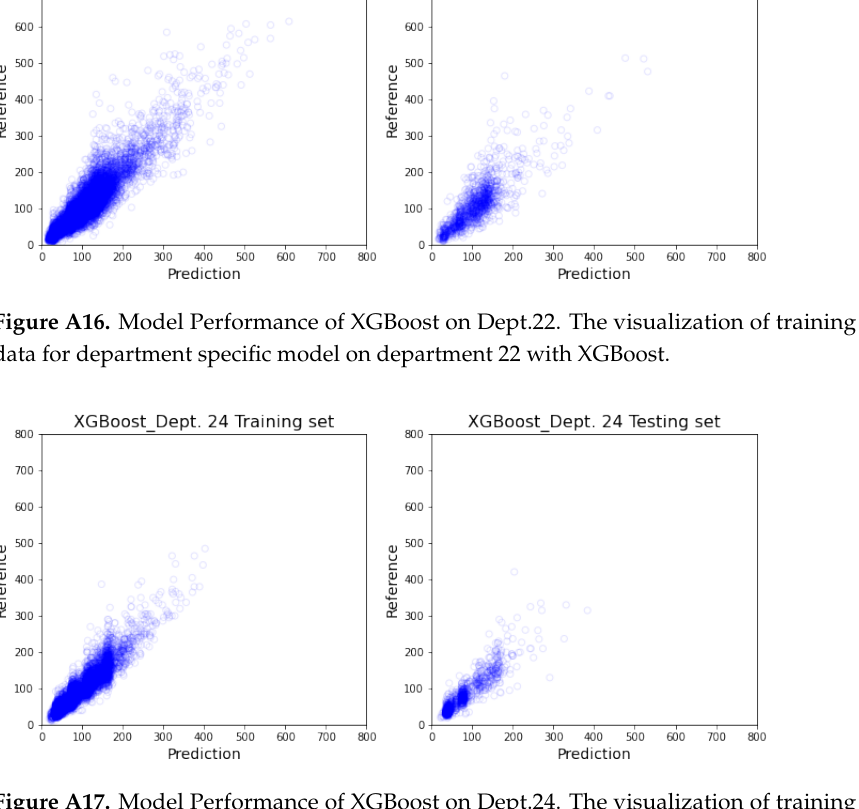
Figure A17. Model Performance of XGBoost on Dept.24. The visualization of training and testing data for department specific model on department 24 with XGBoost.